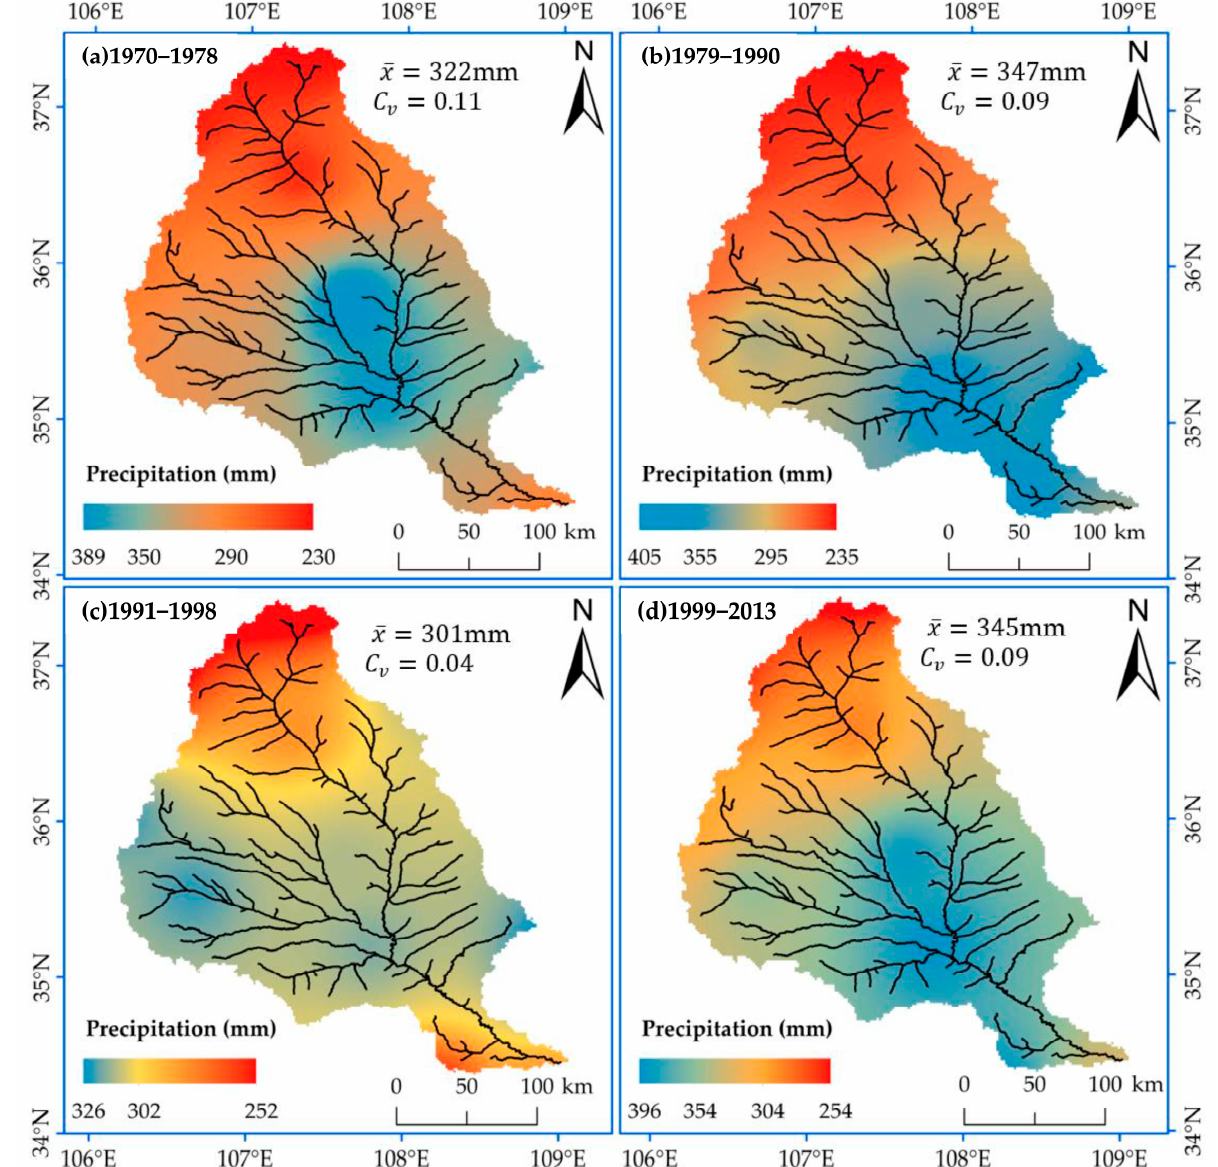
Figure 7. Spatial distribution map of the precipitation in flood season; ( a ) natural period 1970–1978; ( b ) human activity interference period (I) 1979–1990; ( c ) human activity interference period (II)